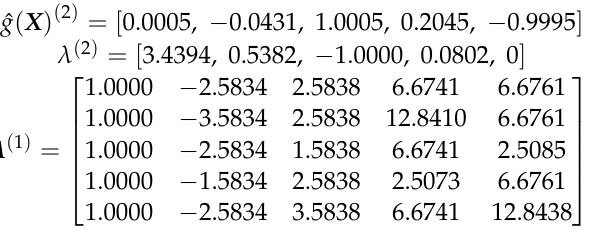
Table 1. Iterative process for solving Example 1.